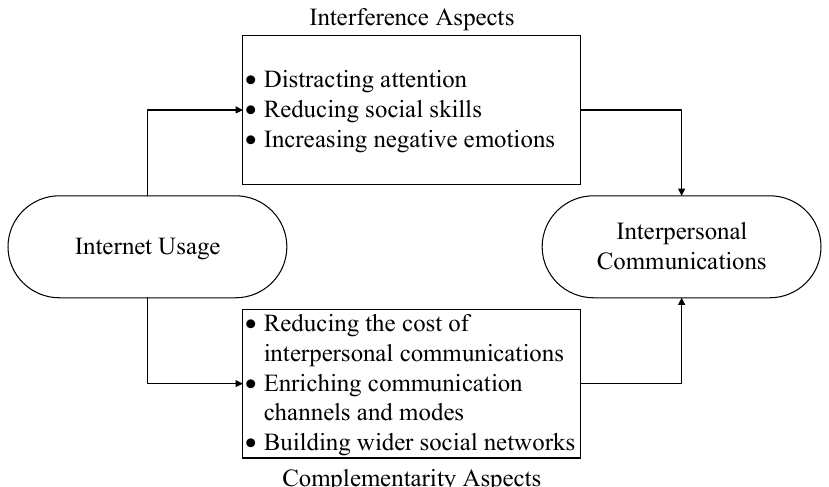
Figure 1. The theoretical framework of the